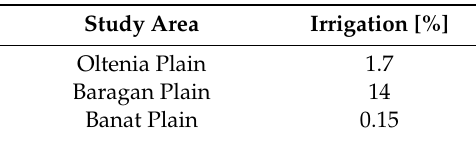
Table 1. Share of irrigated areas (% of total arable land /